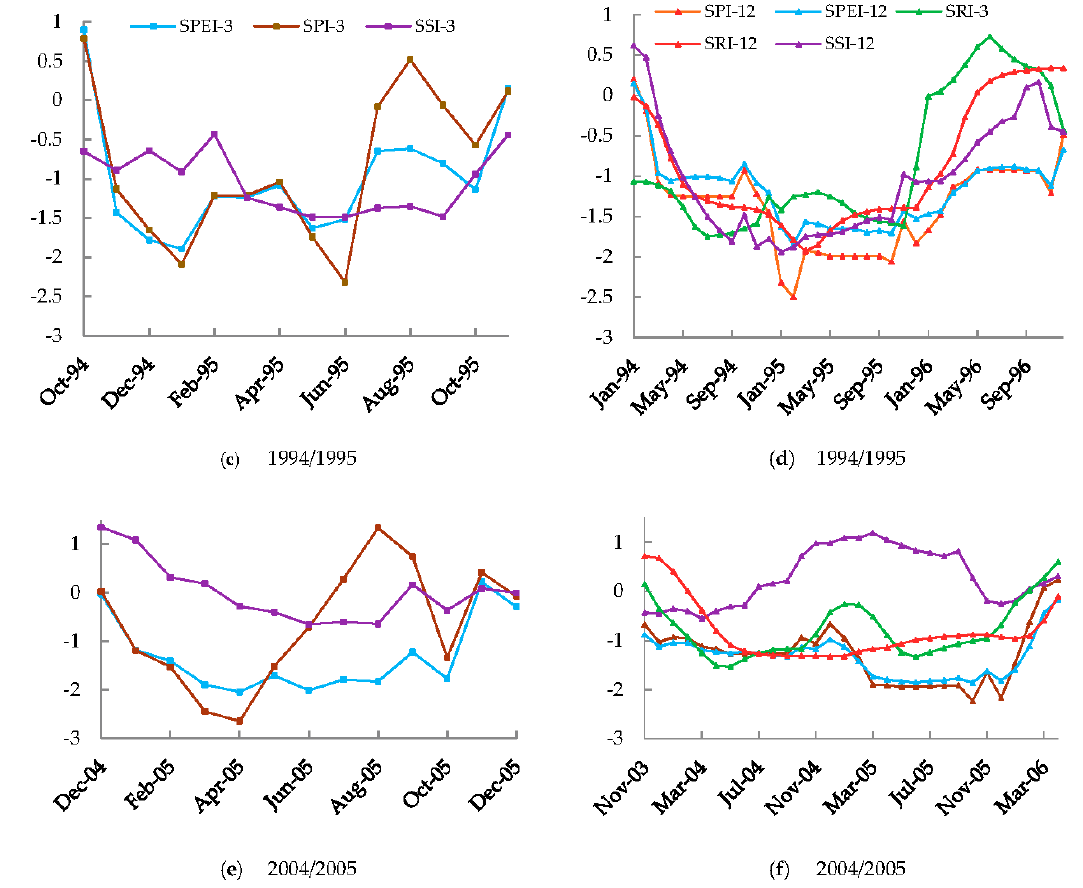
Figure 5. Evolution of major droughts during 1991/1992, 1994/1995 and 2004/2005: ( a , c , d ) meteorological and agricultural indices; and ( b , d , f ) hydrological indices.